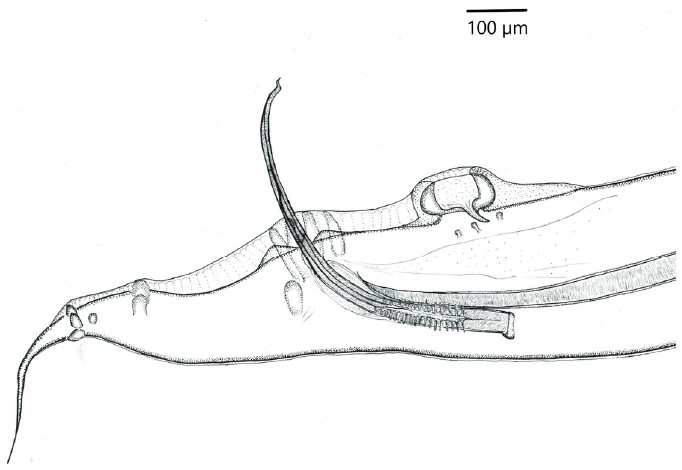
Figure 2. Vulvar area in female Capillaria phasianina. The arrow indicates the tubular appendage. The eggs are elongated, with a thick shell with visible protruding polar plugs. They are jar- or barrel-shaped. The end of the female body is a rounded tail.